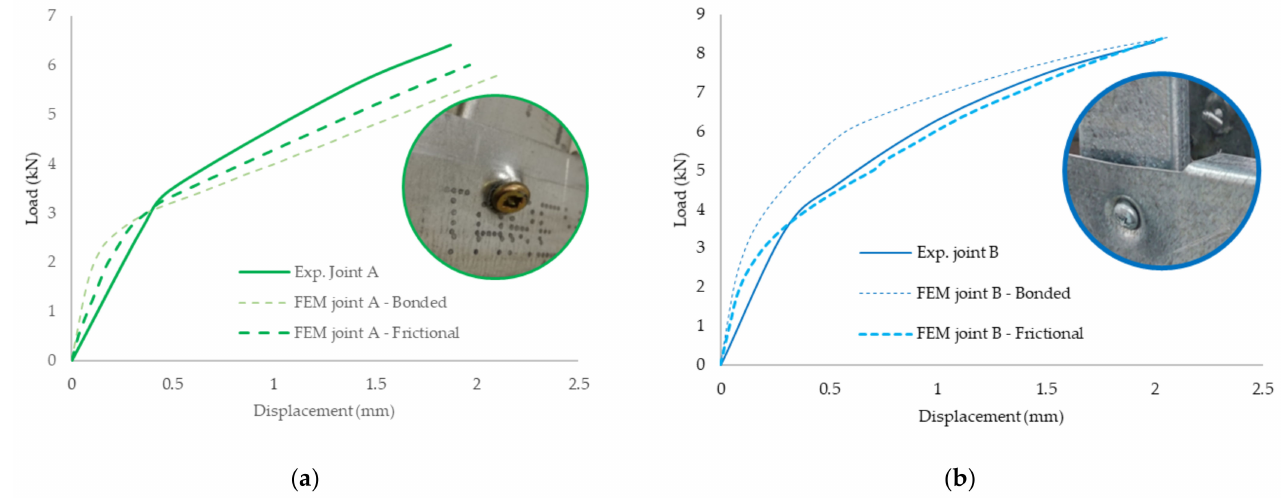
Figure 37. Comparative load–displacement curves: ( a ) joint A; ( b ) joint B.